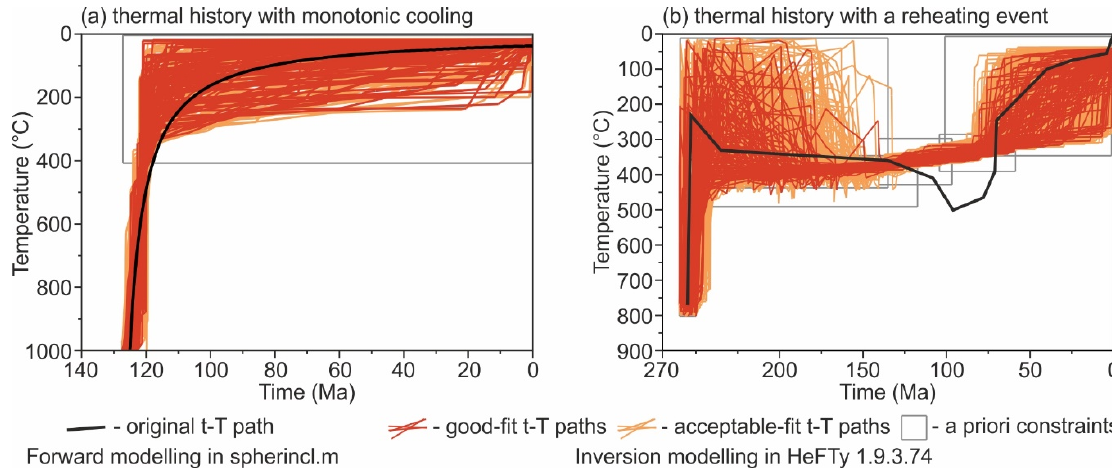
Figure 4. A comparison of t-T paths that were obtained using HeFTy [5] for our synthetic bulk-grain 206 Pb/ 238 U dates of apatite inclusions in alkali feldspar (in red and orange) with the original thermal histories simulated in spherincl.m (black line). We originally assumed flux-limited boundary behaviour with Kd = 5, while inversion modelling assumed open boundary behaviour. ( a ) The case of monotonic cooling history. ( b ) The case of a thermal history with a reheating event. Good-fit reconstructed t-T paths have p > 0.5, while acceptable-fit ones have p > 0.05. Table 1. 206 Pb/ 238 U dates that were used for inversion modelling in HeFTy.